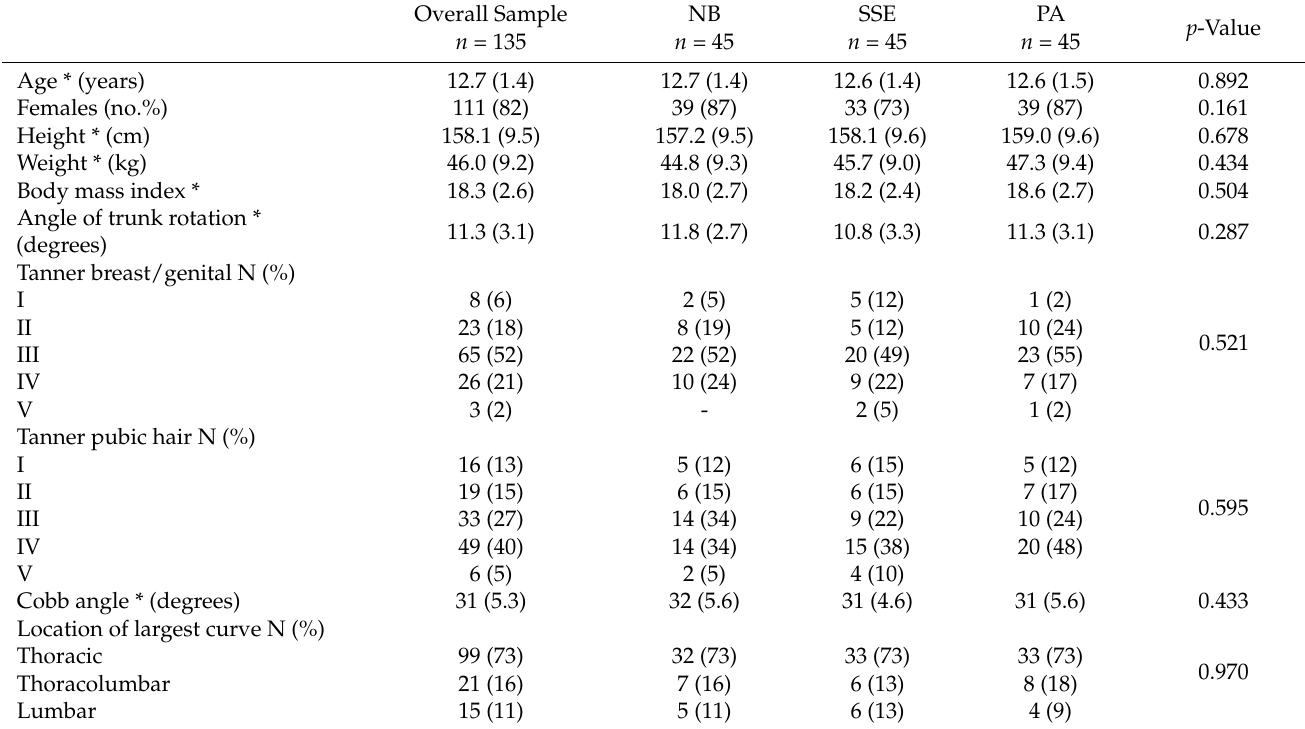
Table 1. Baseline characteristics of the included